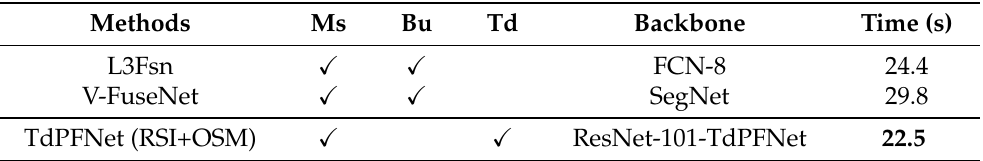
Table 4. The GPU inference times of various models. Ms: Multi-source. Bu: Bottom-up. Td: Top-down. The number in bold is the maximum